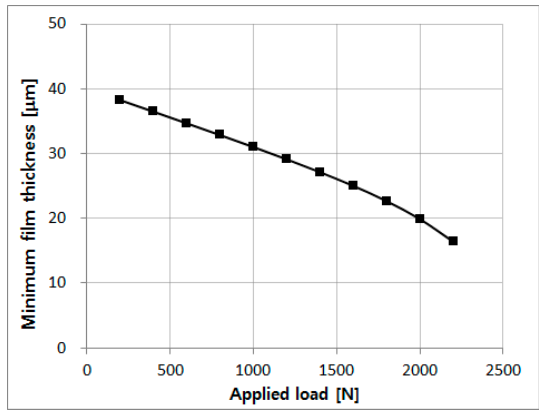
Figure 7. Minimum film thickness versus applied load.